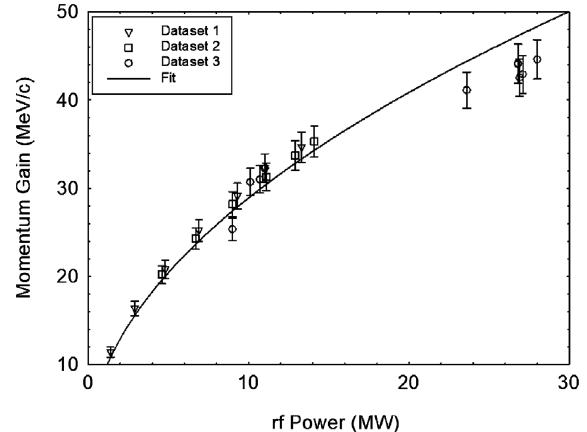
FIG. 33. Momentum from the 10 Hz photoinjector as a function of the rf phase relative to crest for the gun in the CLARA position.